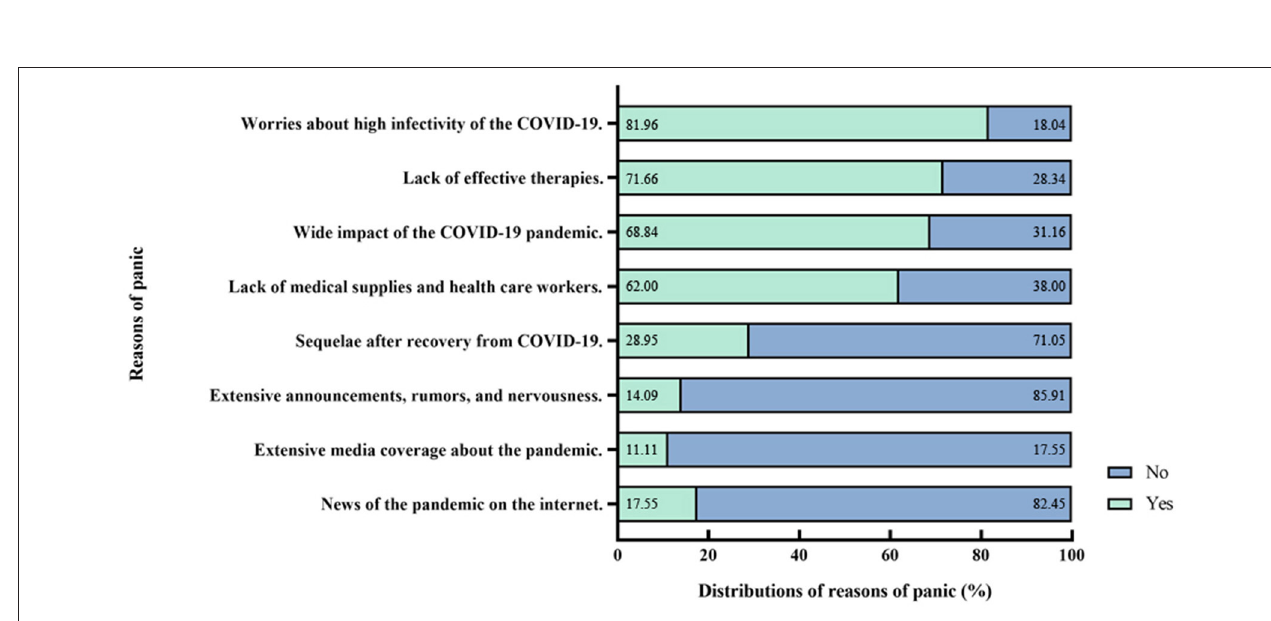
FIGURE 3 | Risk perception of the Coronavirus Disease-2019 (COVID-19) pandemic and distributions of panic.